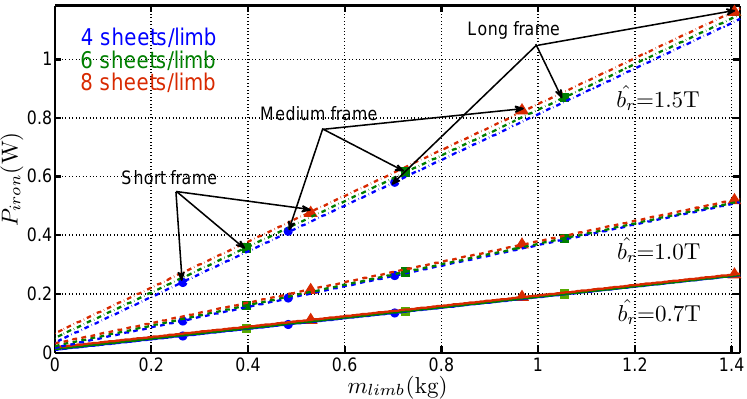
Figure 5. Variations of P iron with m limb for frame equipped of four, six and eight samples per limb